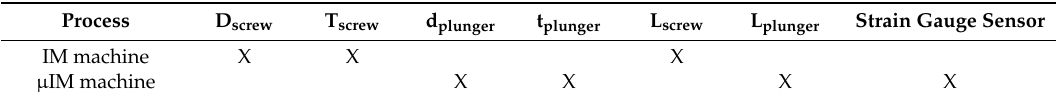
Table 5. Feature blocks of the injection phase for the two machines.